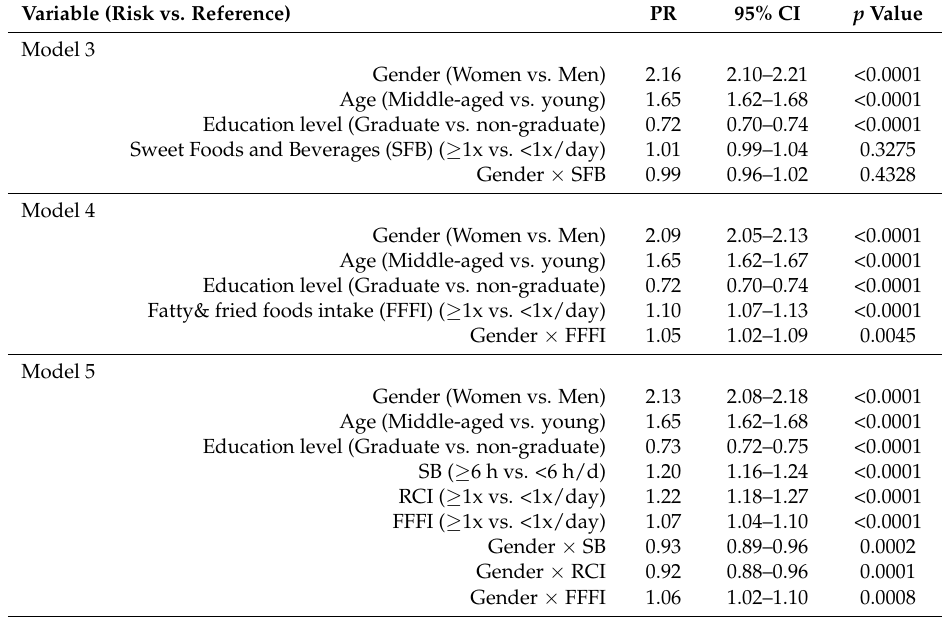
Variable (Risk vs.